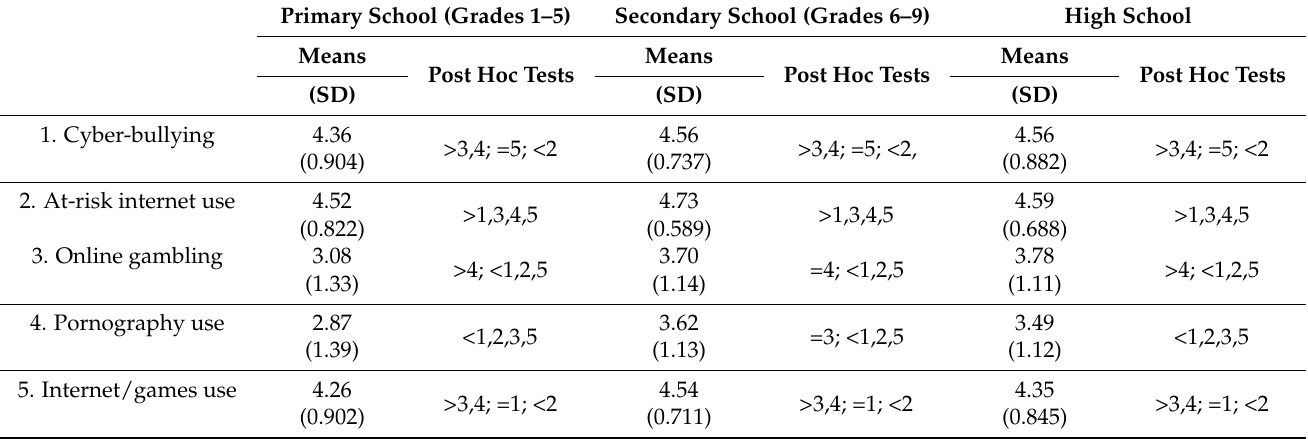
Table 1. The perceived importance of conducting prevention interventions focused on screen-related risks during the fall 2020 wave of long-term distant schooling caused by COVID-19 in primary (n = 1068), secondary (n = 934), and high schools (n = 451). The response scale was 1 to 5.